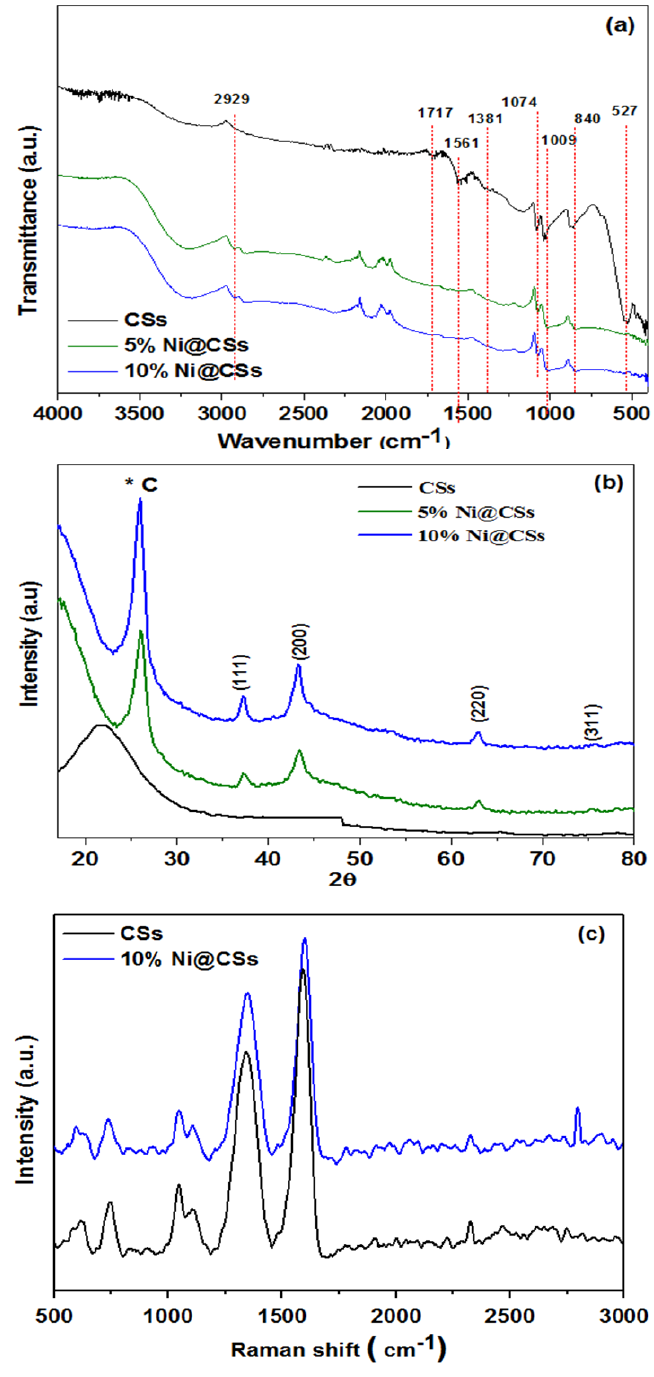
Figure 1. ( a ) FT − IR spectra, ( b ) XRD diffraction patterns, and ( c ) Raman spectra of CSs and Ni@CS composites.